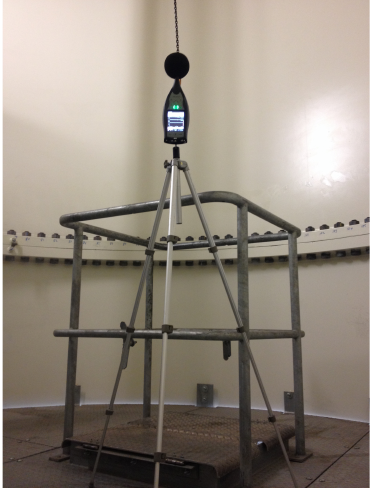
Figure 10. Sound pressure level meter at the center of the tower.